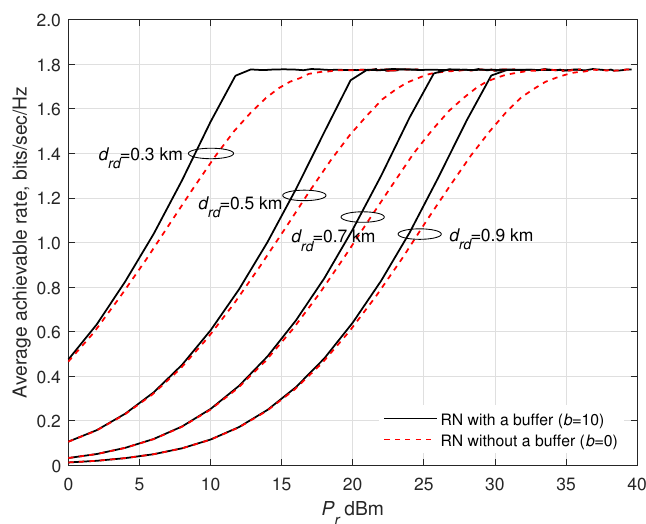
Figure 4. Average achievable rate when P s = 23 dBm, b = 10, and d sr = 0.6